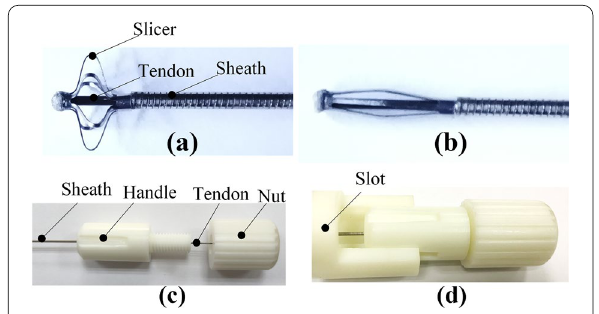
Figure 4 Instrument for scratching the endometrium